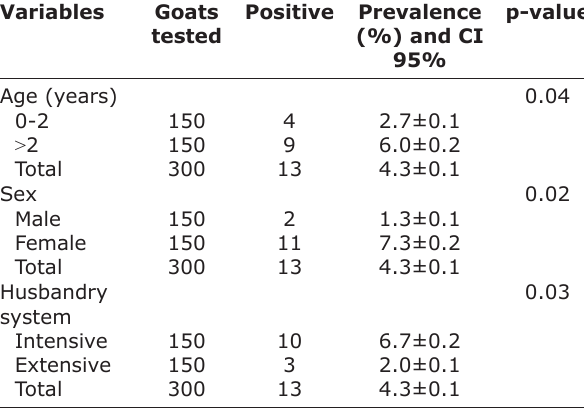
Table-4: Seroprevalence of brucellosis by age, sex, and breeding system of goats collected in the Province of Bam in Burkina Faso,